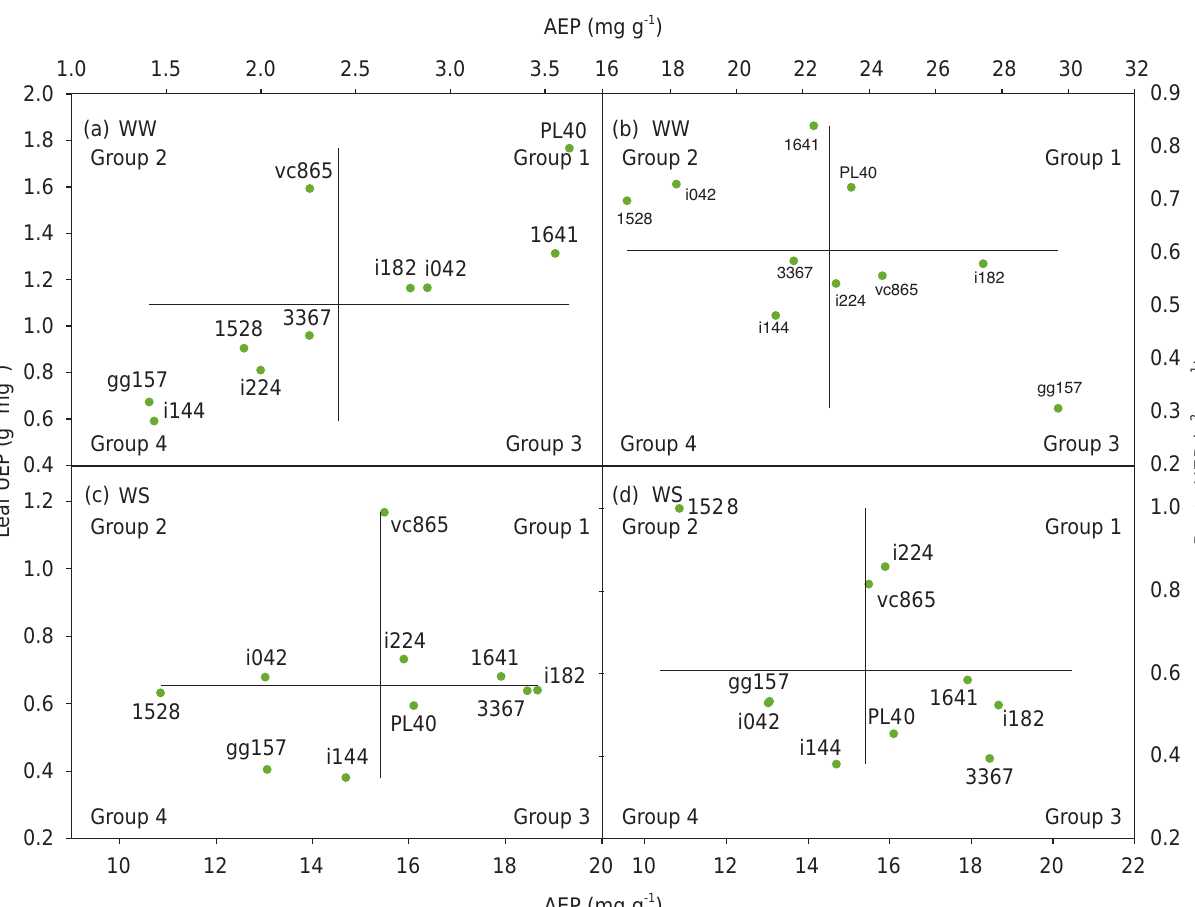
Figure 6. Phosphorus absorption efficiency (AEP) and P use efficiency in leaves (leaf UEP) (a) and roots (root UEP) (b) of well-watered (WW) plants; and P absorption efficiency (AEP) and P use efficiency in leaves (leaf UEP) (c) and roots (root UEP) (d) of water-stressed (WS) seedlings of ten Eucalyptus